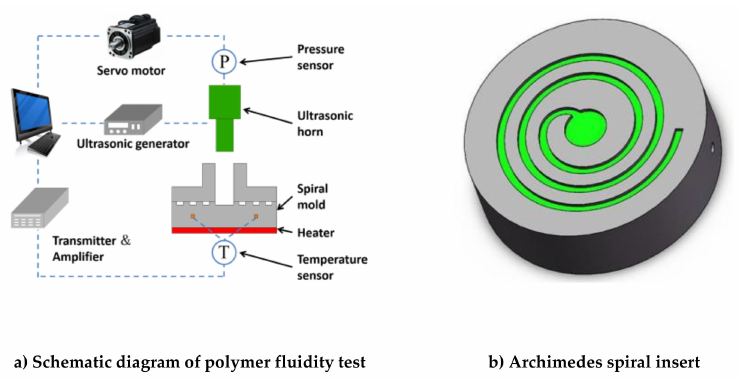
Figure 1. Ultrasonic microinjection molding equipment.